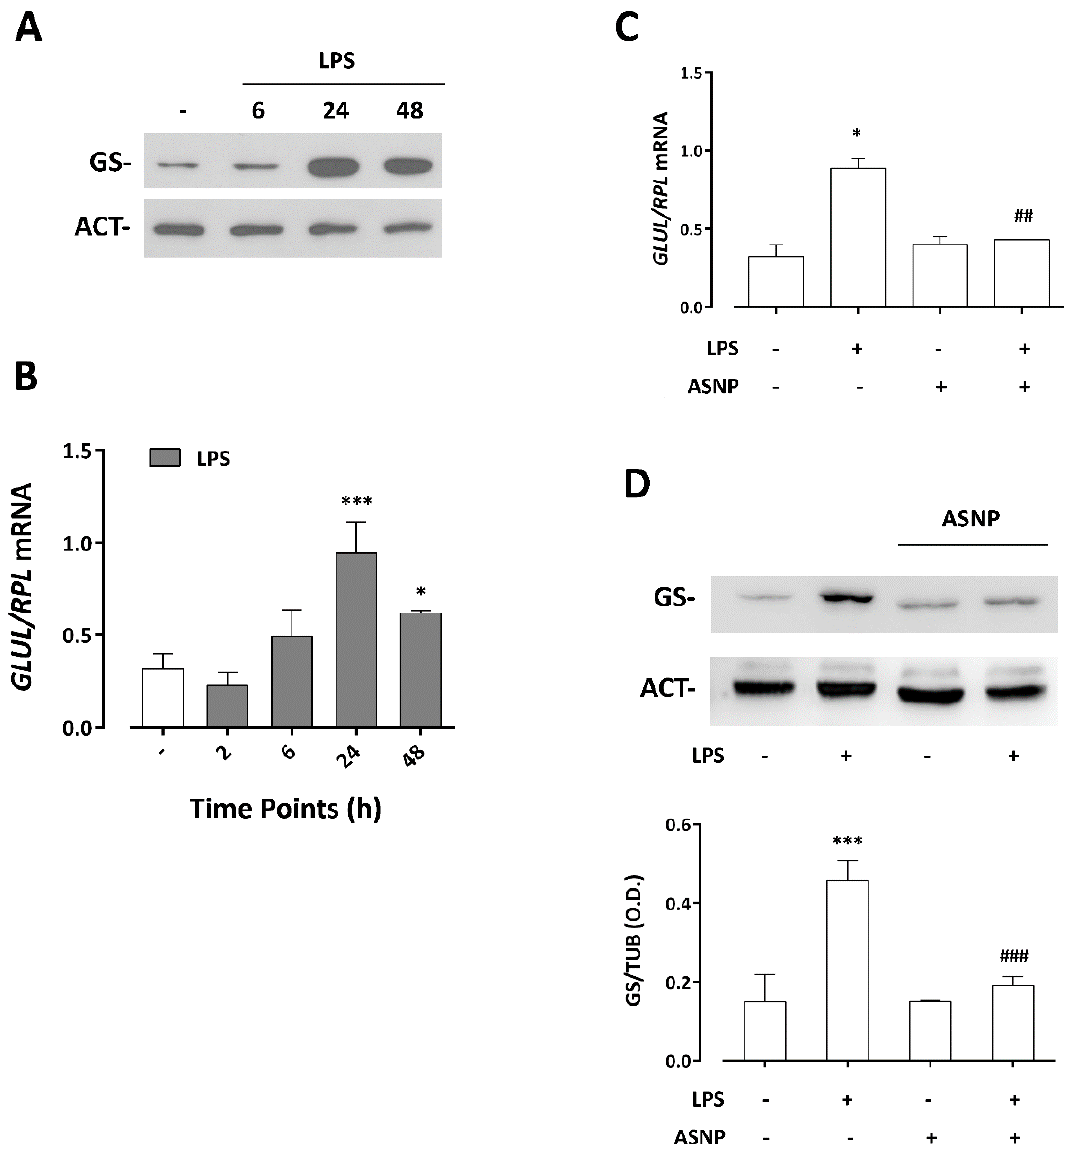
Figure 5. Effect of LPS treatment on GS expression in human macrophages exposed to ASNP. ( A , B ). Macrophages were treated with LPS for the times indicated and then processed for either Western blot or RT − PCR analysis. ( A ), A representative Western blot performed twice with comparable results. ( B ), The relative expression of GLUL mRNA. Data are means of four determinations ± SD obtained from two independent experiments. ( C , D ), Cells were treated as described for Figure 2 and then processed for RT − PCR or Western blot. ( C ), The relative expression of GLUL mRNA. Data are means of four determinations ± SD obtained from two independent experiments. ( D ), A representative Western blot along with the relative abundance of GS protein is reported. Data are the means of three independent experiments ± SD. For all the panels, * p < 0.05, *** p < 0.001 vs. control; ## p < 0.01, ### p < 0.001 vs. 1 ng/mL LPS. ( B , D ), One − way ANOVA followed by Tukey’s multiple comparison test; ( C ), two − tail t − test for unpaired data.